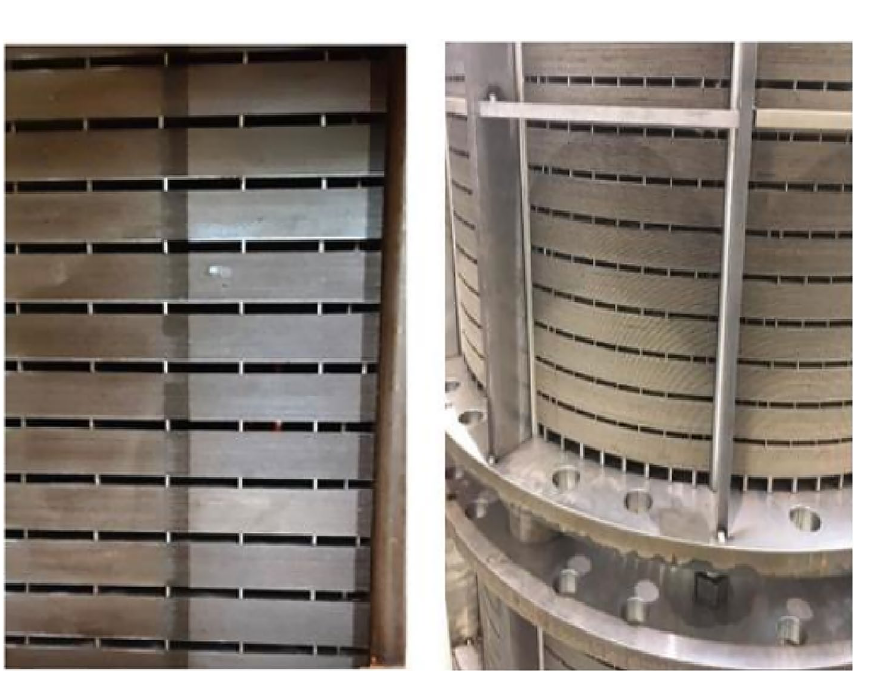
Figure 2. View of two industrial stators (with airvent spacers).